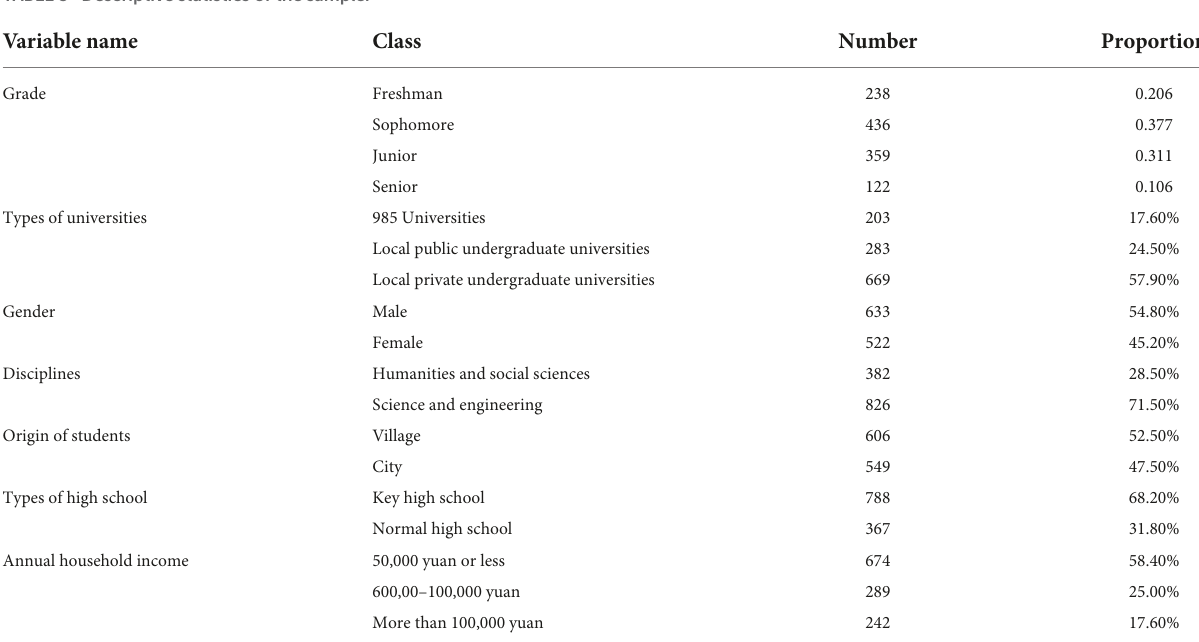
TABLE 3 Descriptive statistics of the